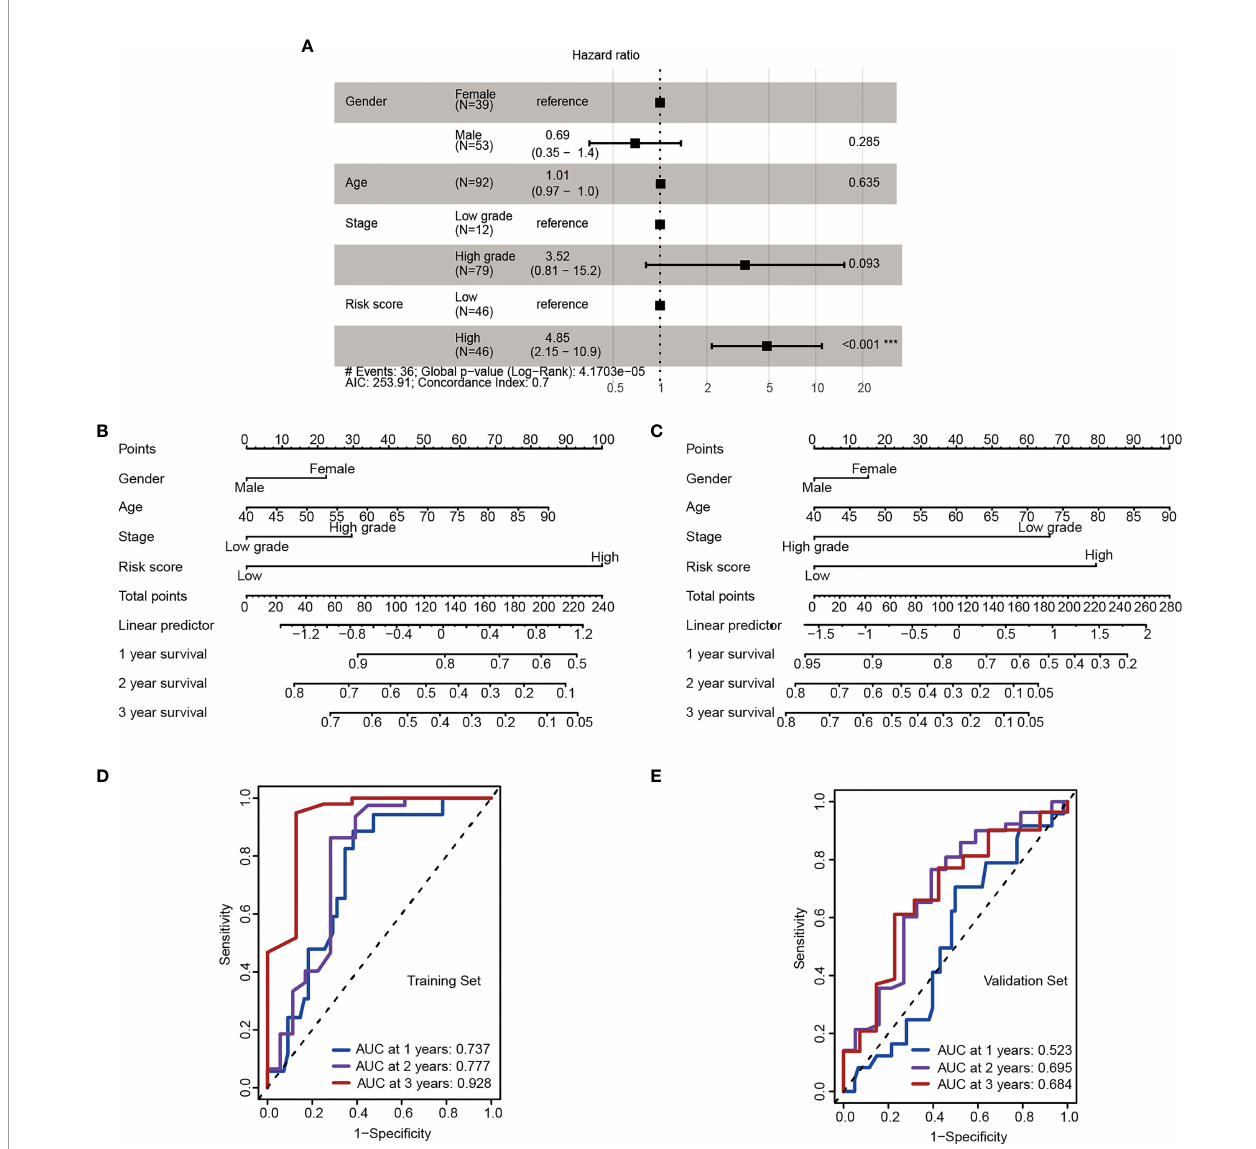
FIGURE 4 | The 4-miRNA strati fi cation signature is an independent risk factor. (A) Forest plot depicting hazard ratios and 95% con fi dence intervals of the univariate signi fi cant clinicopathological variables. Parameters colored in black are signi fi cant risk factors in multivariate analysis (Wald test, ***P < 0.001). (B, C) Nomogram derived from the combination of high- and low-risk group strati fi cation and key clinicopathological parameters in the training (B) and the validation cohort (C) . (D, E) ROC for 1-, 2-, 3- year OS in the training (D) and the validation cohort (E)